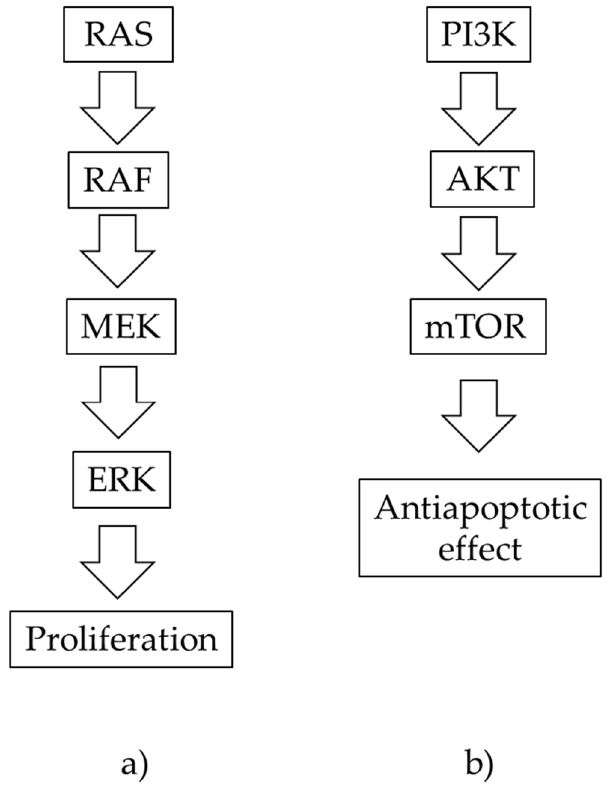
Figure 1. A simplified scheme of the most studied signaling pathways for the development of melanoma: ( a ) MAPK pathway, ( b ) PI3K pathway.